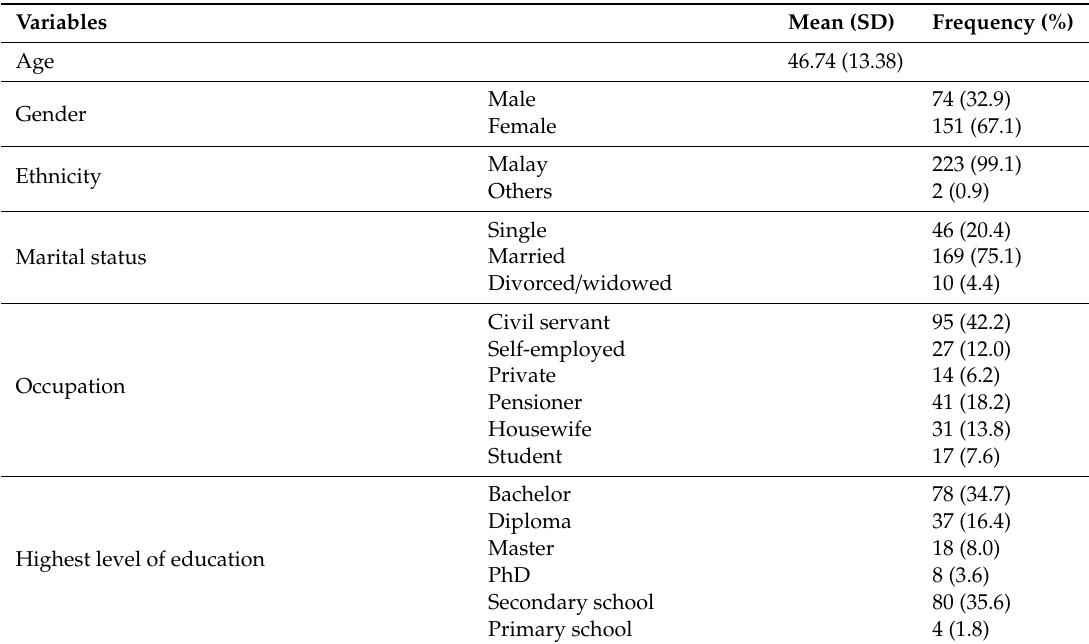
Table 1. Characteristics of the study respondents ( n =